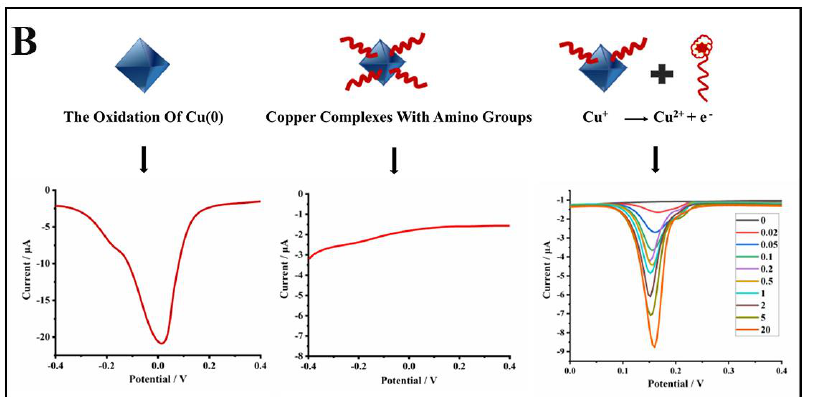
Figure 1. Schematic illustration of the electrochemical aptasensor based on the N–doped Cu–metallic organic framework (N–Cu–MOF) for selective detection of deoxynivalenol (DON). ( A ) Preparation of the aptasensor. ( B ) Mechanisms of the sensing system.